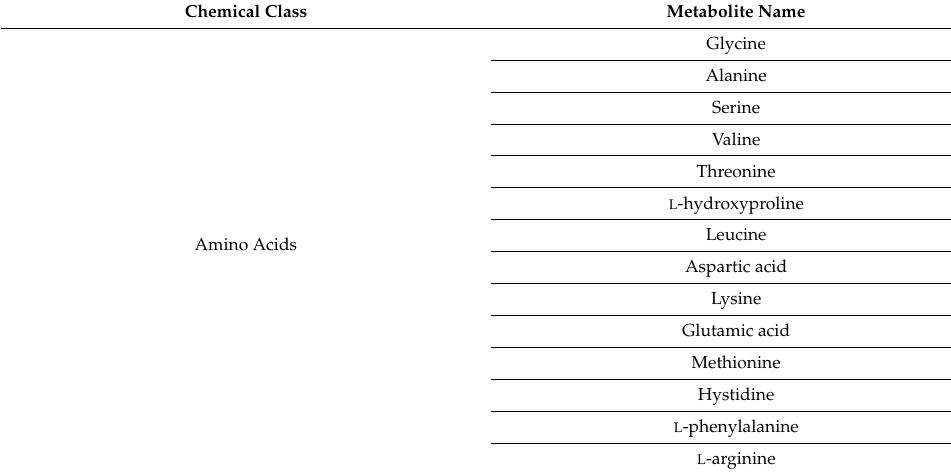
Table 3. Classification of metabolites from Artemisia annua sample on various chemical